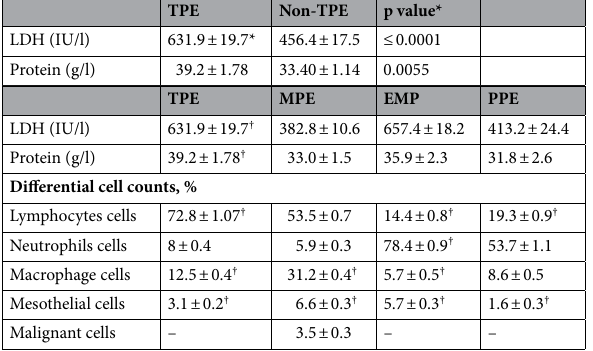
Table 2. Biochemical and cytological characteristics of pleural effusions*. *Values are presented as mean ± standard error of the mean (SEM). Comparisons of data between TPE and non-TPE groups were performed using Student’s t test. † Values are shown as mean ± SEM. TPE tuberculous pleural effusion, MPE malignant pleural effusion, EMP Empyema, PPE Parapneumonic.